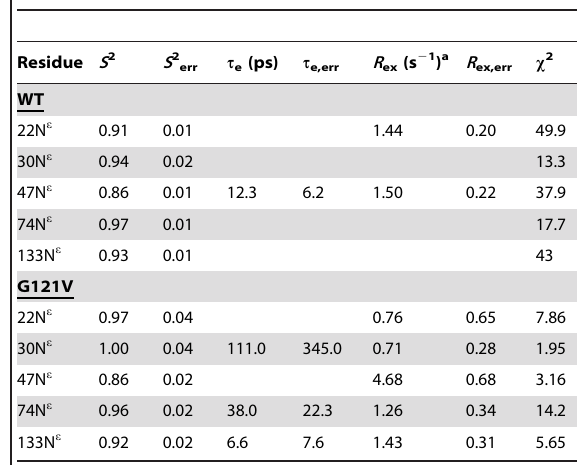
Table 1. Model-free analysis of tryptophan indole 15 N relaxation within E:NADPH:MTX and E G121V :NADPH:MTX complexes.